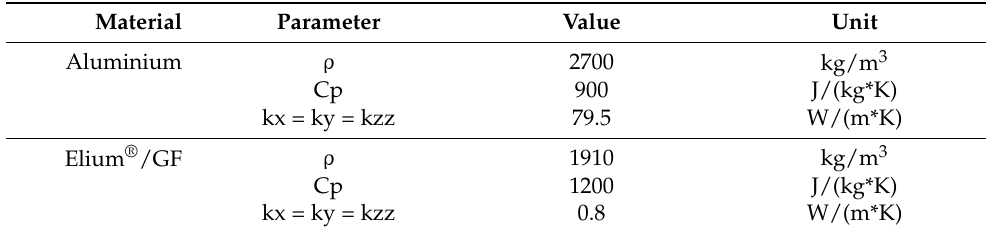
Table 2. Thermal properties of the glass/Elium ® components and aluminium mould used in the thermal simulation of the polymerisation curing process.